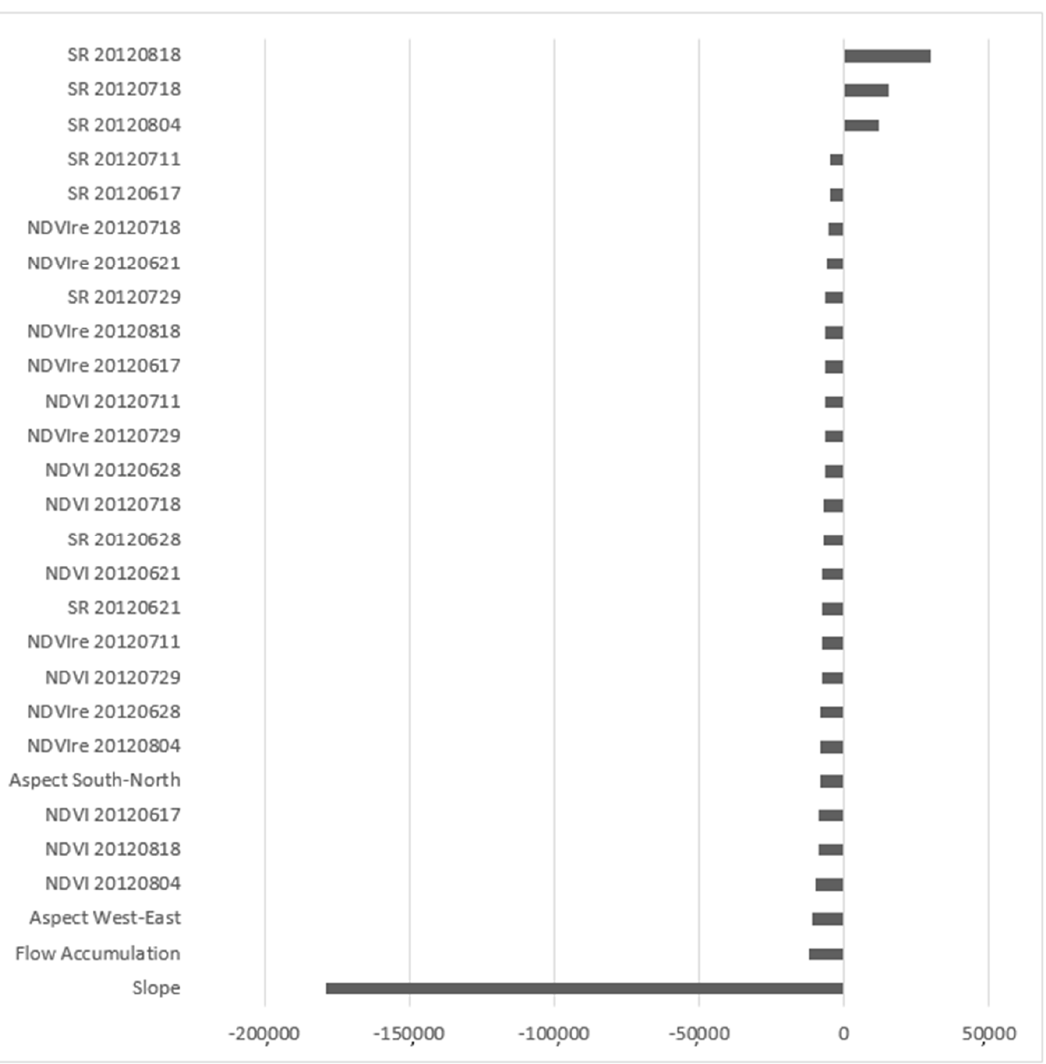
Figure A8. Importance of variables for the corn 2012 ANN model, as measured by Connection weights (larger positive or negative values indicate higher